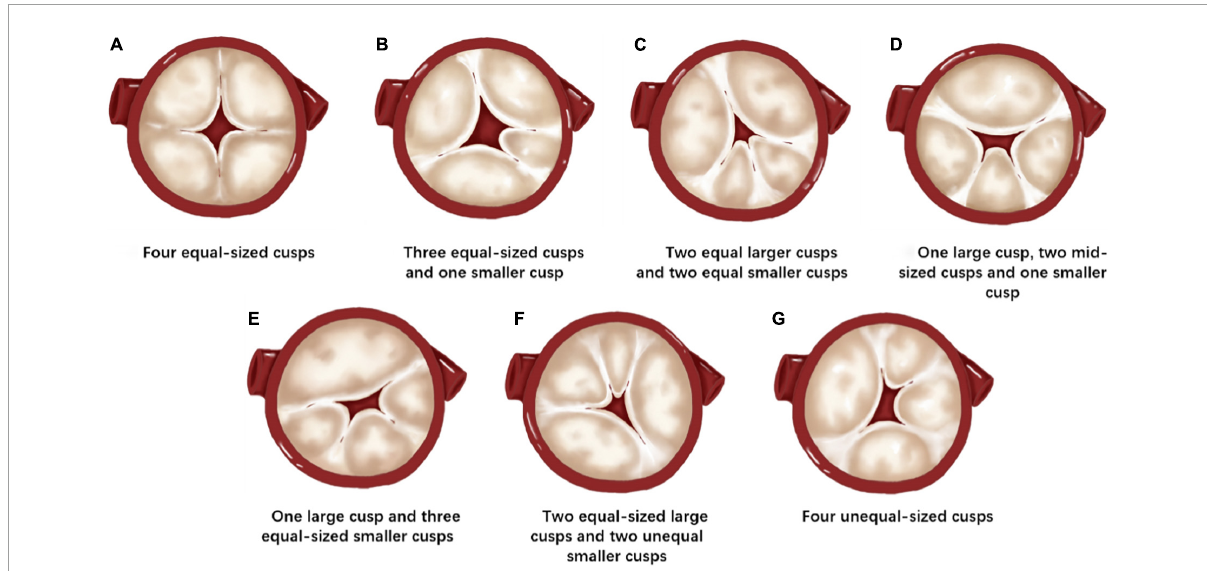
FIGURE4 Hurwitz and Roberts classification of the quadricuspid aortic valve (QAV). (A) QAV with four equal-sized cusps. (B) QAV with three equal-sized cusps and one smaller cusp. (C) QAV with two equal larger cusps and two equal smaller cusps. (D) QAV with one larger cusp, two mid-sized cusps, and one smaller cusp. (E) QAV with one larger cusp and three equal-sized smaller cusps. (F) QAV with two equal-sized large cusps and two unequal smaller cusps. (G) QAV with four unequal-sized